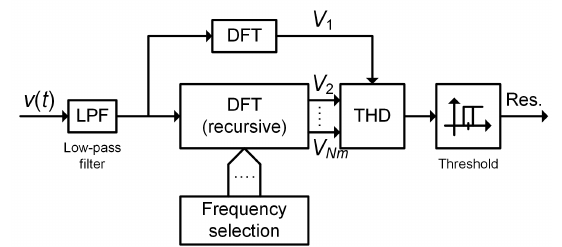
Figure 11. Resonance detection using the recursive DFT and harmonics